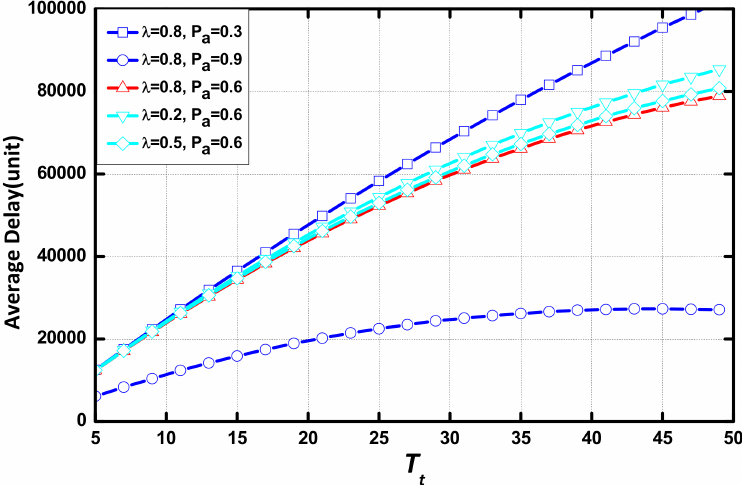
Figure 8. Average delay vs. T t with different ( λ , P α